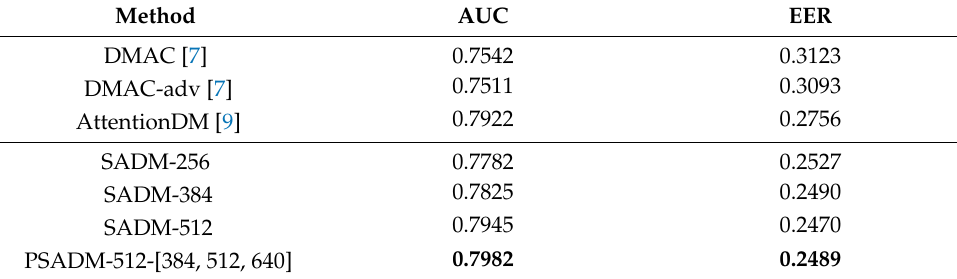
Table 6. Comparisons on